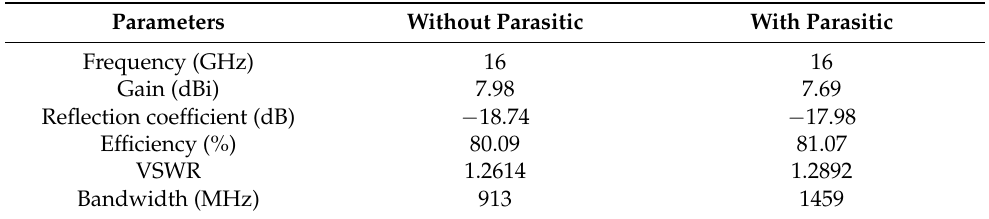
Table 1. Single-element antenna performance with and without C-shaped parasitic structure.